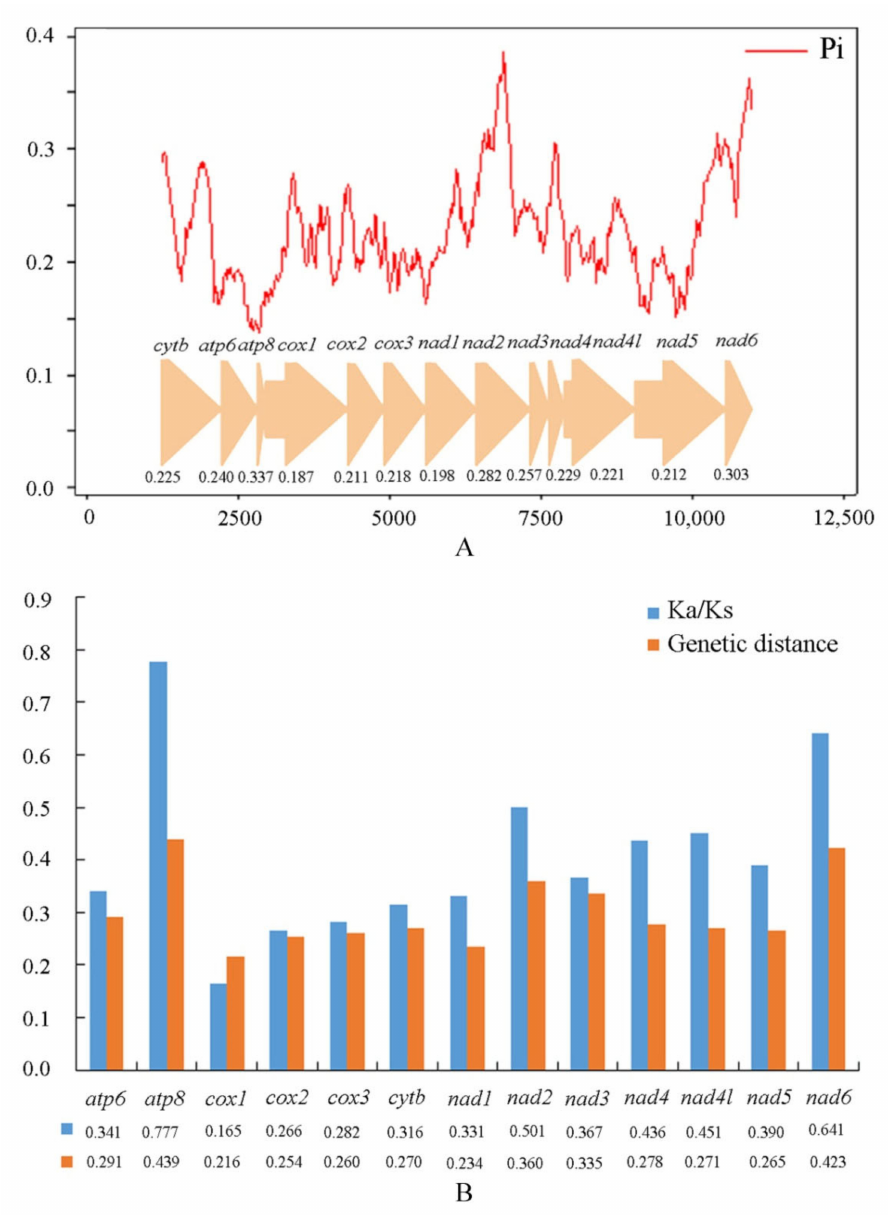
Figure 3. ( A ) The nucleotide diversity (Pi) of 13 protein-coding genes of mitogenome among 33 species of Lampyridae in a sliding window analysis (a sliding window of 200 bp with the step size of 20 bp); the Pi value of each gene is shown under the gene name. ( B ) Genetic distances and the ratio of non-synonymous (Ka) to synonymous (Ks) substitution rates of 13 protein-coding genes among 33 species of Lampyridae. The average value for each PCGs is shown under the gene